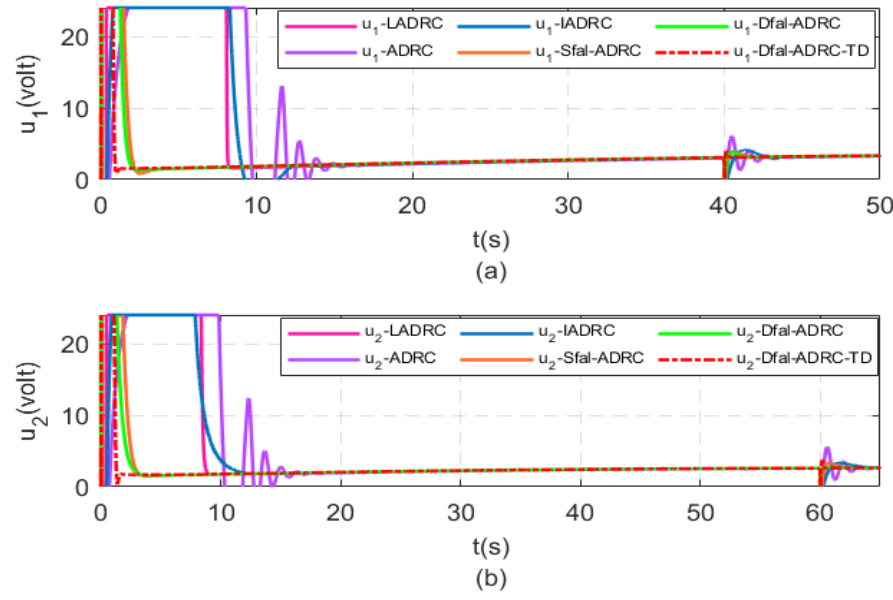
Figure 7. The control signal when using the 2 nd MADRC scheme. ( a ) 1 st subsystem. ( b ) 2 nd sub-